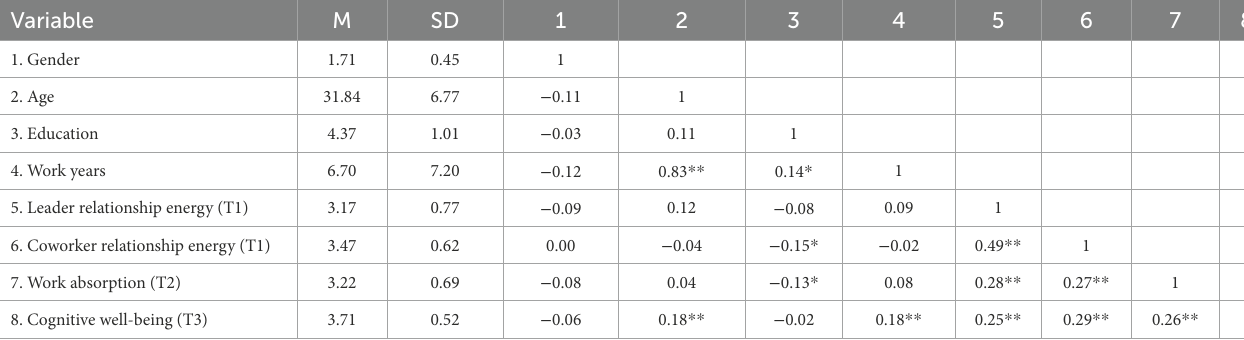
TABLE 3 Descriptive statistics and correlations of current study. Variable